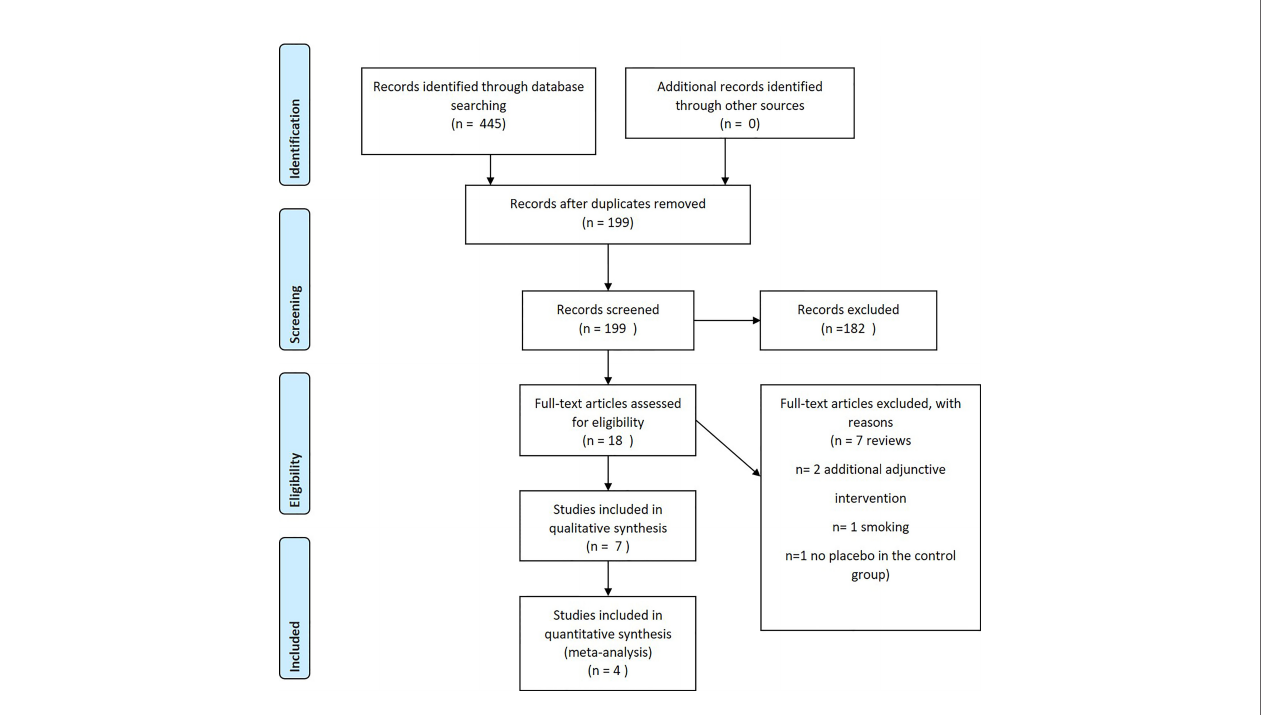
FIGURE 1 | Preferred Reporting Items for Systematic Review and Meta-analyses fl ow diagram describing the selection